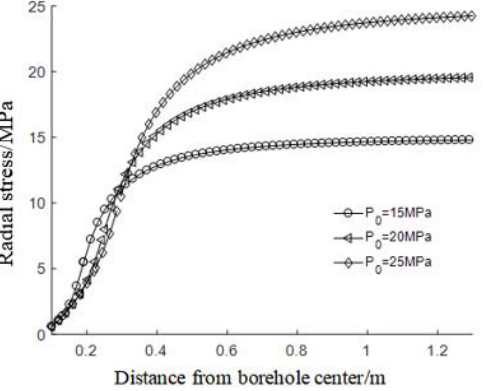
Figure 2. Variation in radial stress around a borehole under different ground stresses.